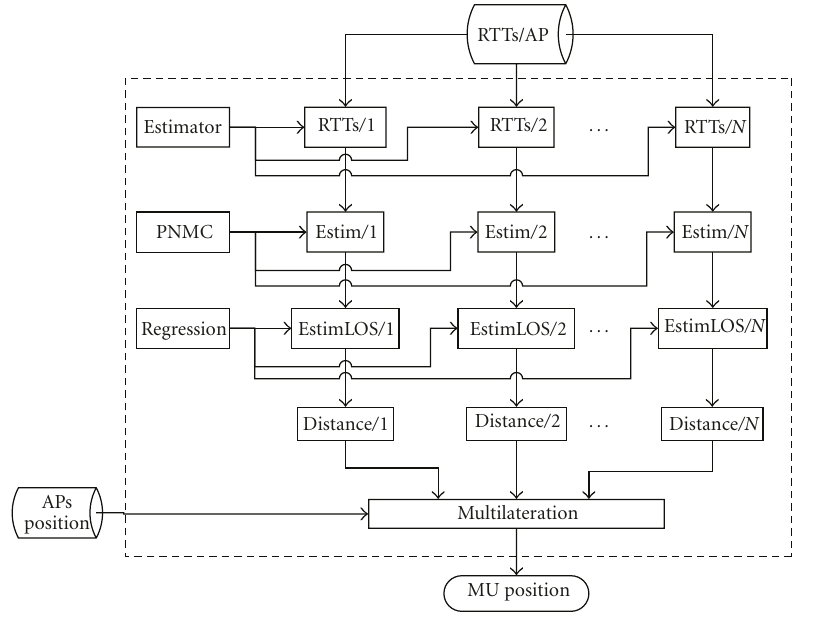
Figure 2: Flowchart of the localization